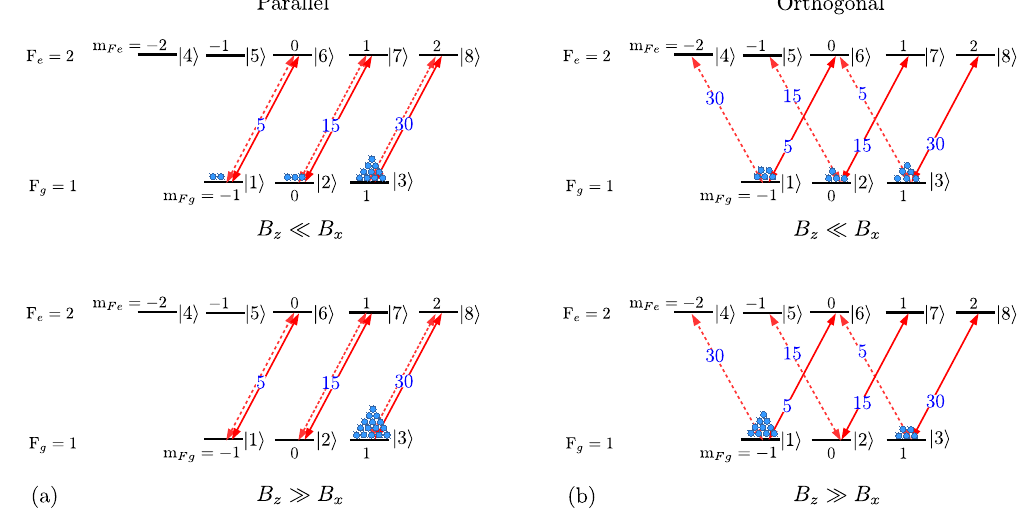
Figure 4. Population redistribution due to optical pumping. ( a ) Probe and control beams with parallel circular polarizations. Upper part for  B B